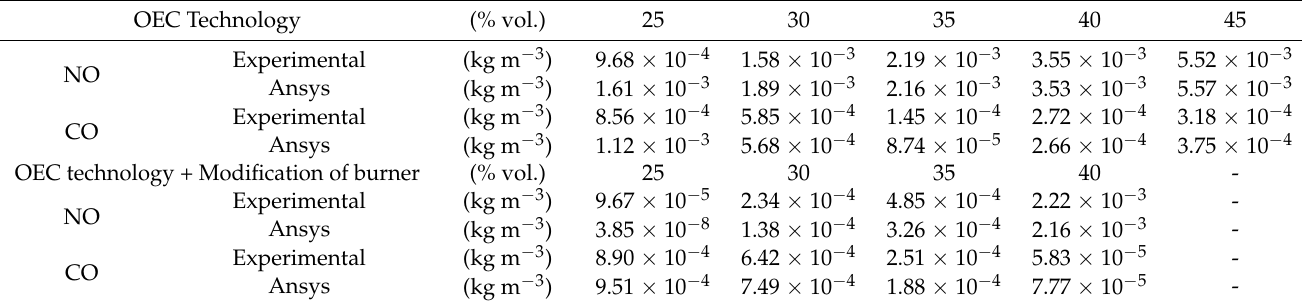
Table A3. Verification of CFD model: NO and CO mass